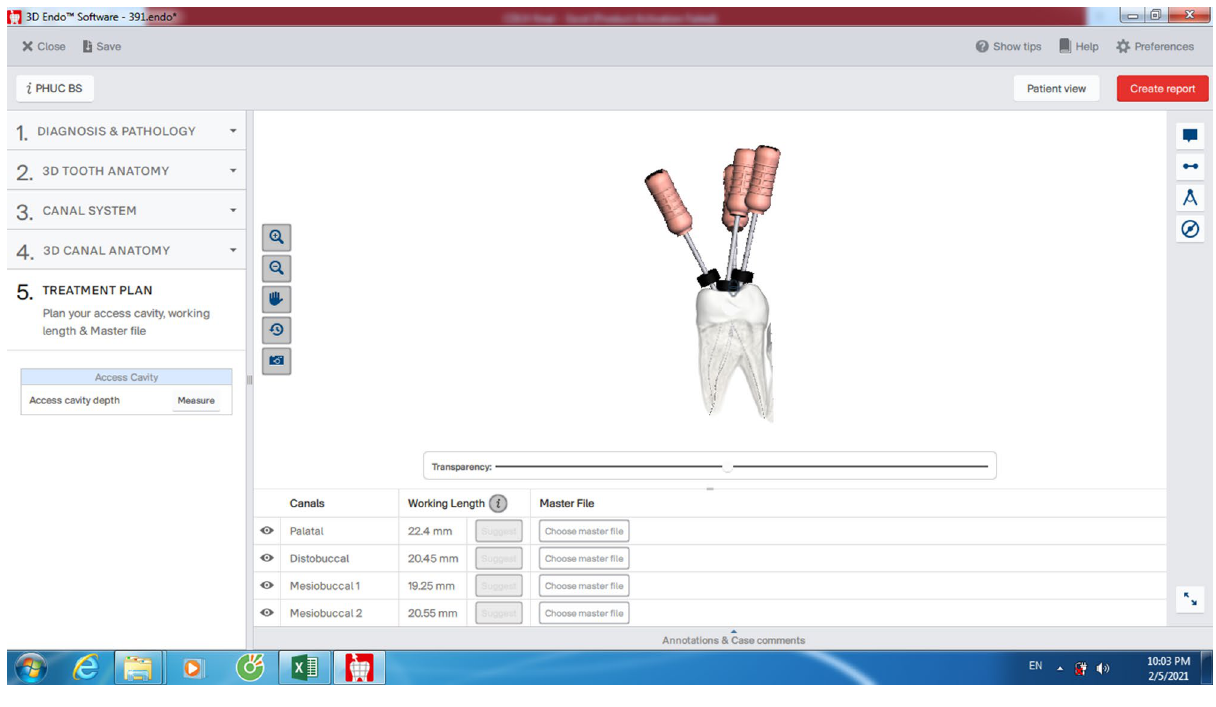
Figure 3. Proposed length measurement on the 3D Endo software.